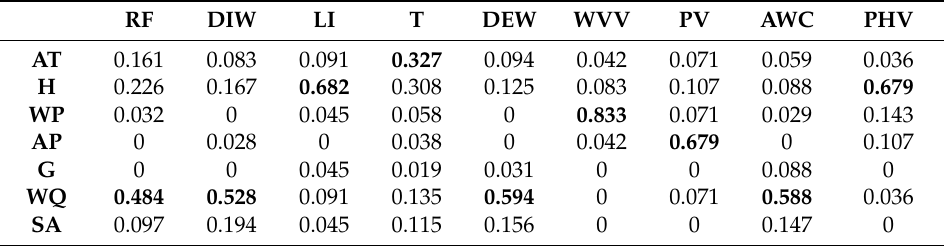
Table 6. Similarity results based on semantic strategy.